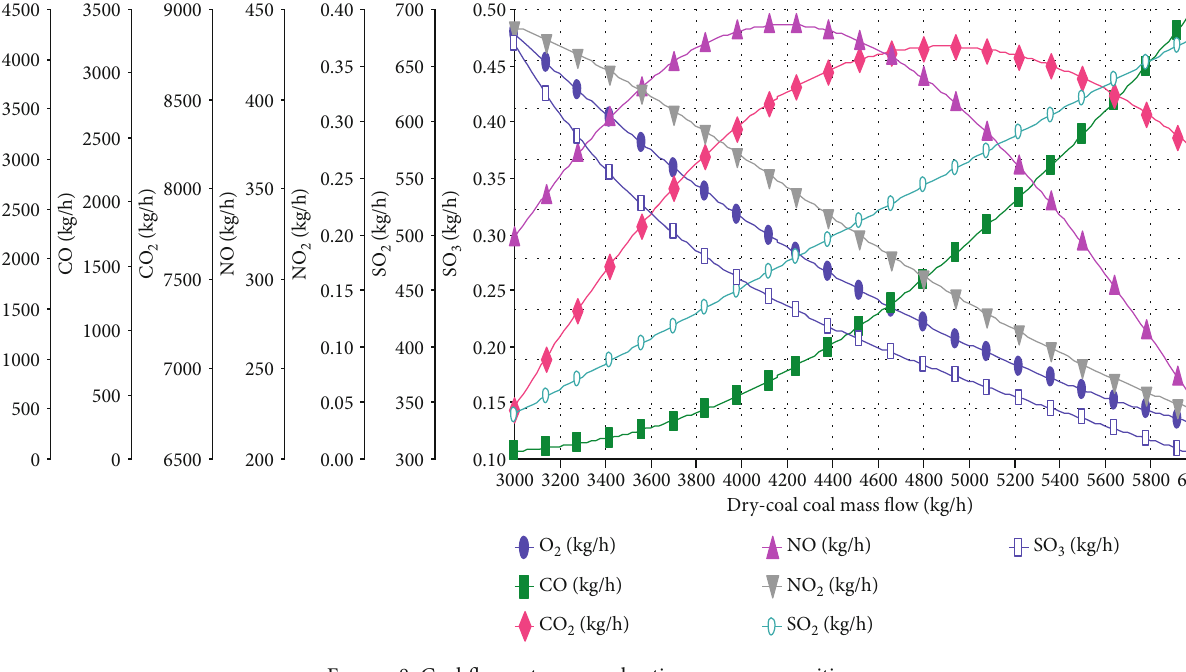
Figure 8: Coal fl ow rate vs. combustion gases composition.